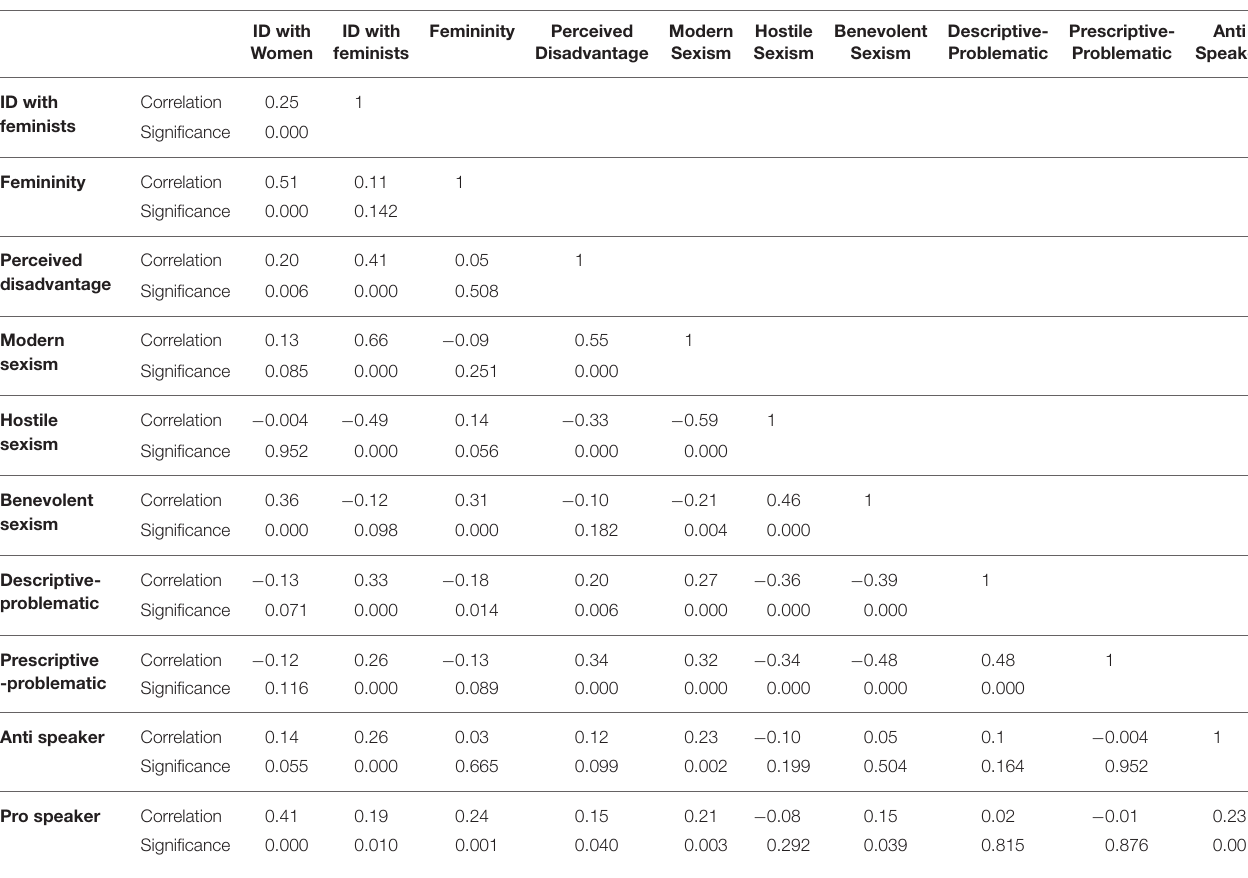
TABLE 4 | Correlation table for Study 3.